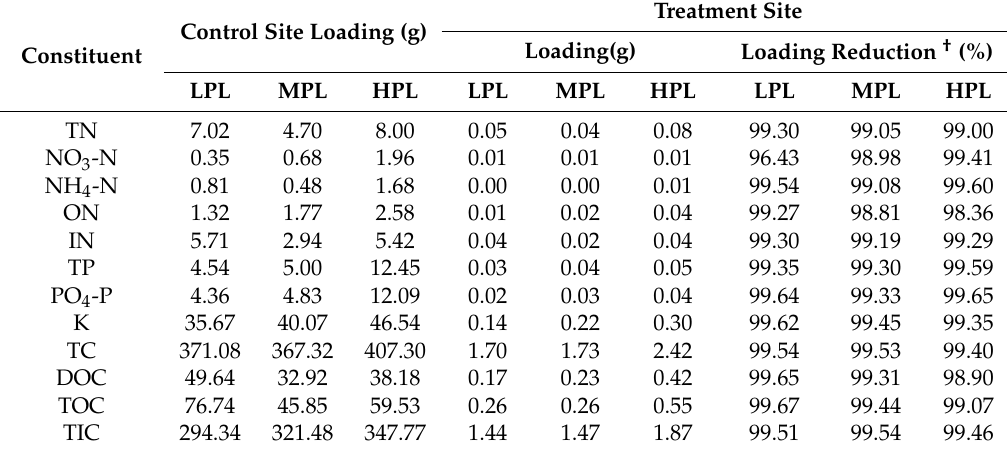
Table 3. Runoff Pollutant Loading